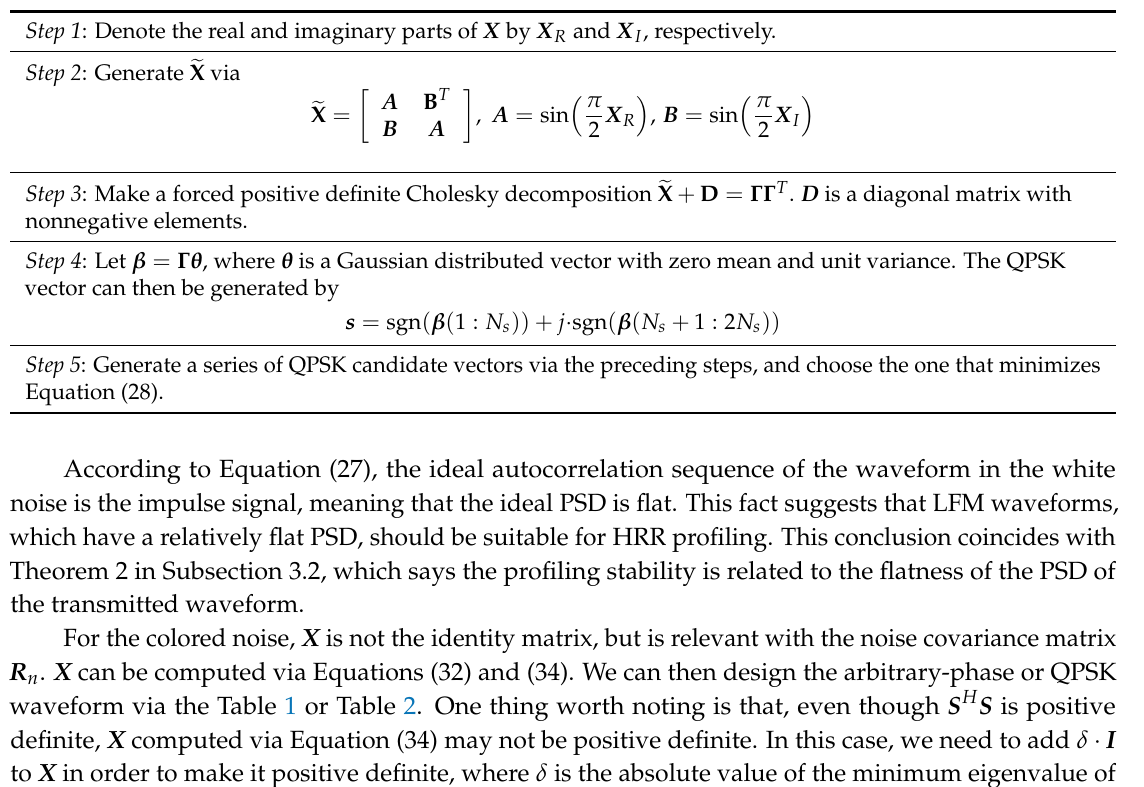
Table 2. Customized Gaussian randomization method for CM QPSK waveform